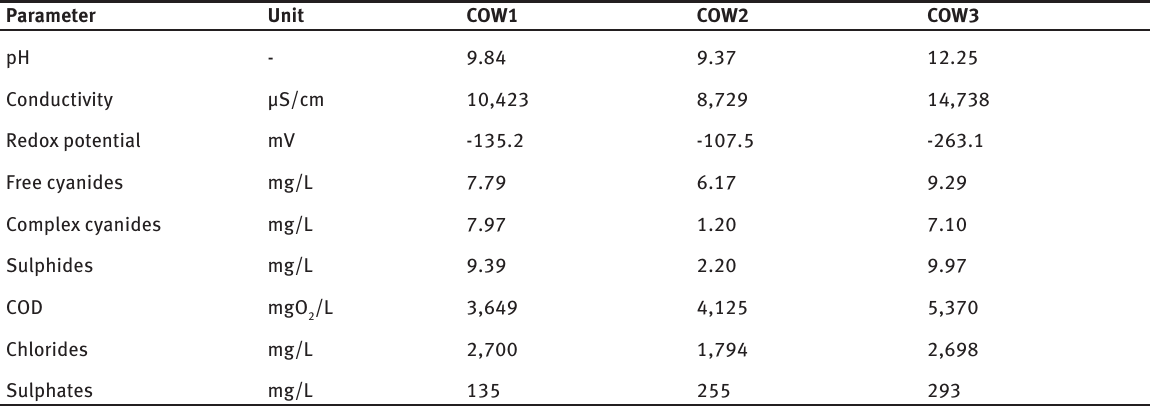
Table 3: Characteristics of coke oven wastewater used in the research.